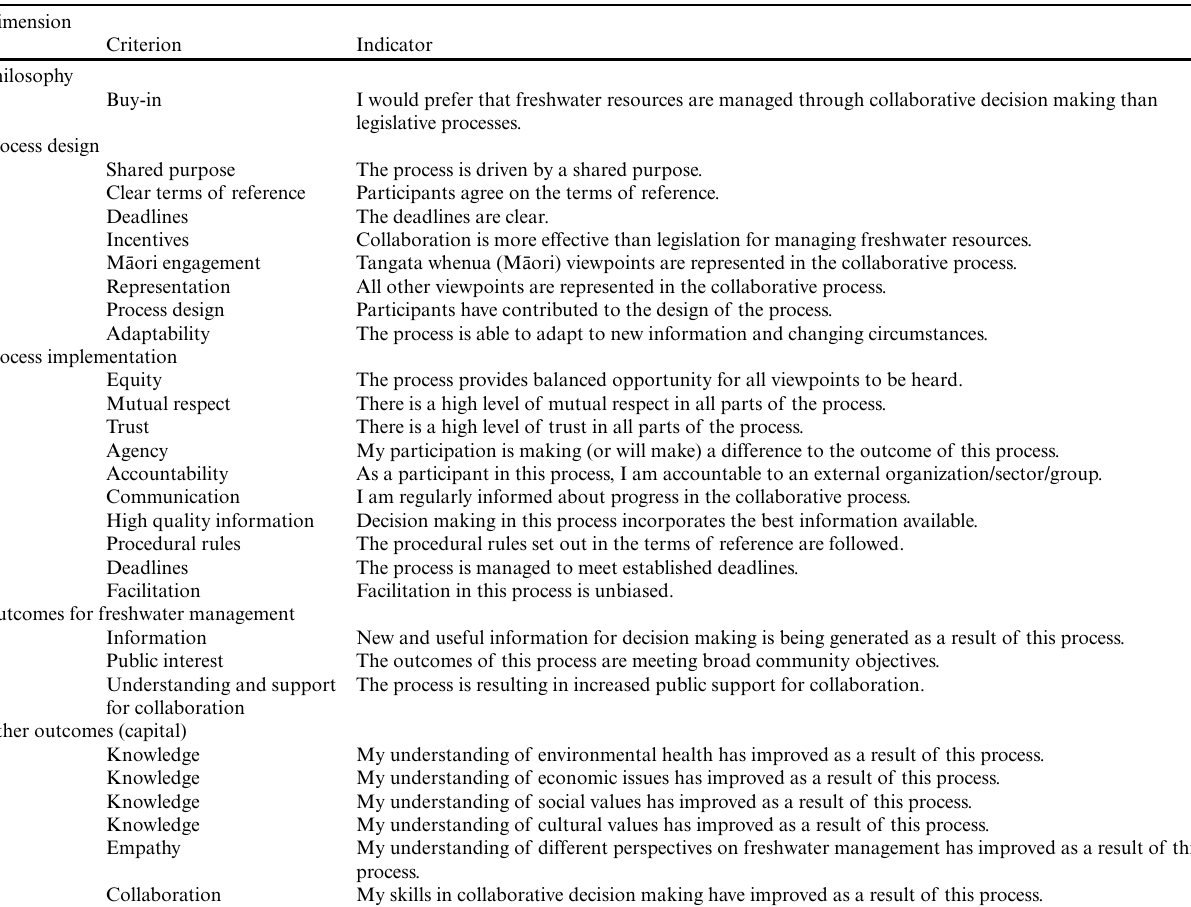
Table 2 . Process design, implementation, and outcome criteria for collaboration (Susskind and Cruikshank 1987, Crowfoot and Wondolleck 1990, Cormick et al. 1996, Wilson et al. 1996, Moote et al. 1997, Gunton et al. 1998, Innes and Booher 1999, Wondolleck and Yaffee 2000, Beierle and Cayford 2002, Susskind et al. 2003, as cited in Frame et al. 2004, Morton et al. 2012) Dimension Criterion Indicator Philosophy